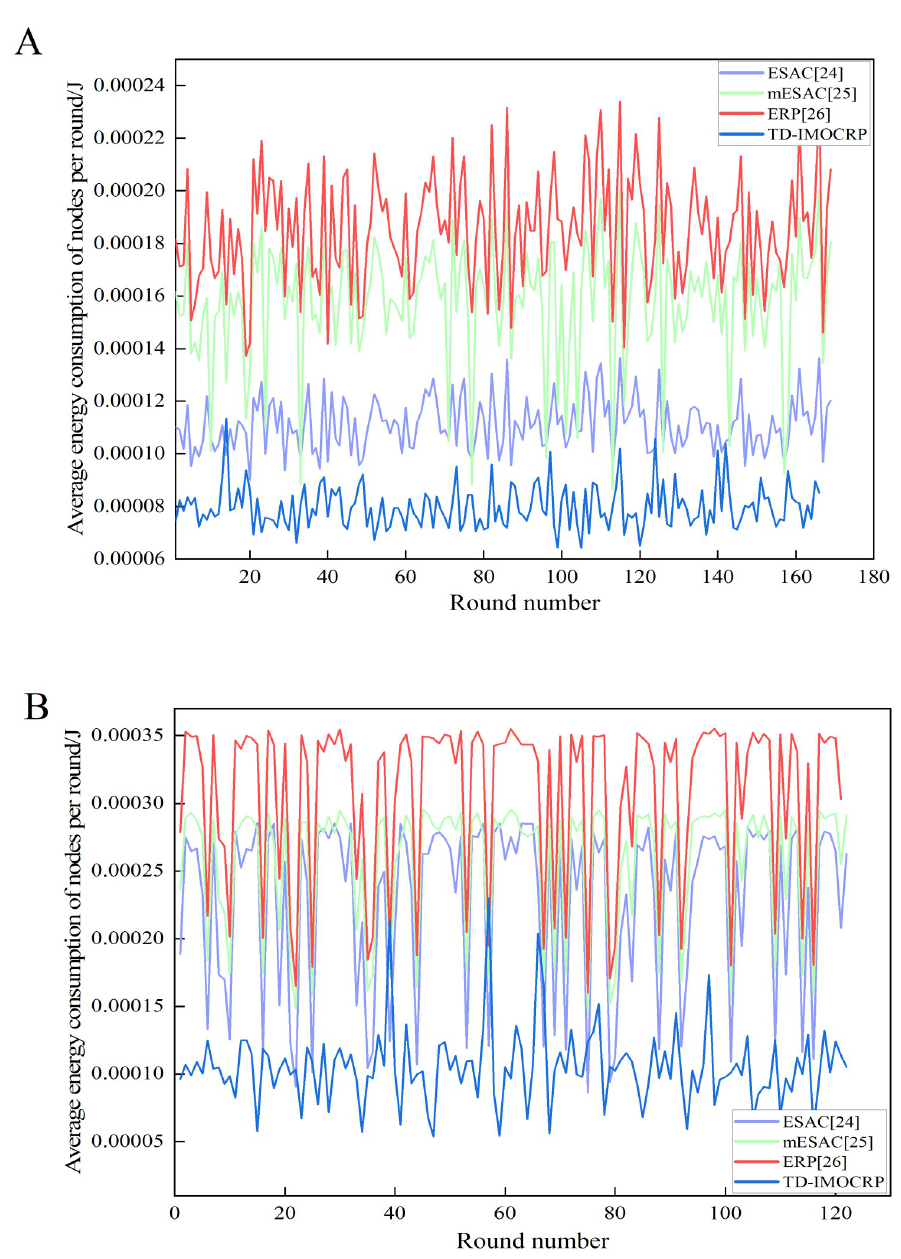
Fig 14. Comparison results of average energy consumption of nodes per round. (A) The sink is located at the center. (B) The sink is located at